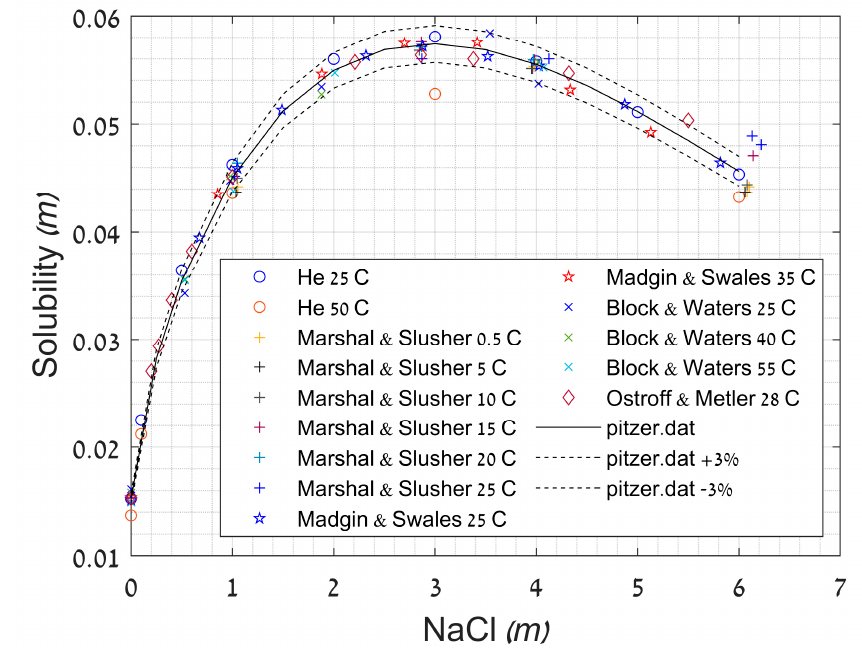
Figure 2. Measured gypsum solubility in 0–6 m NaCl solutions in temperatures ranging from 0.5 to 55 °C. Data points are all based on previous studies [67–71]. The line is based on thermodynamic calculations at 25 °C, while the dashed lines are the theoretical calculation ±3%. The calculations were performed with the Pitzer formalism and the parameterization of Harvie and Weare [46,51,57] as implemented in the Pitzer.dat database of PHREEQC version 2.18.